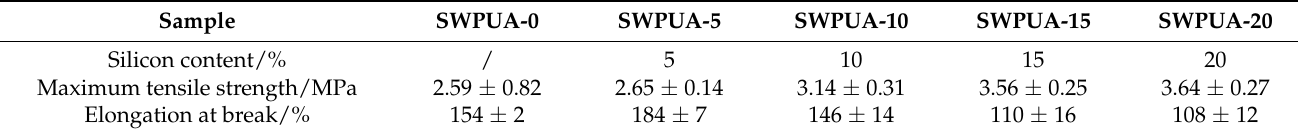
( b ) Figure 7. ( a ) Weight loss curves of SWPUA samples with di ff erent silicon content; ( b ) Derivative of weight loss curves of SWPUA samples with di ff erent silicon content. As shown in the fi gure, the thermal stability of WPU was improved to some extent with the addition of A172. With the introduction of silane coupling agent, the temperature